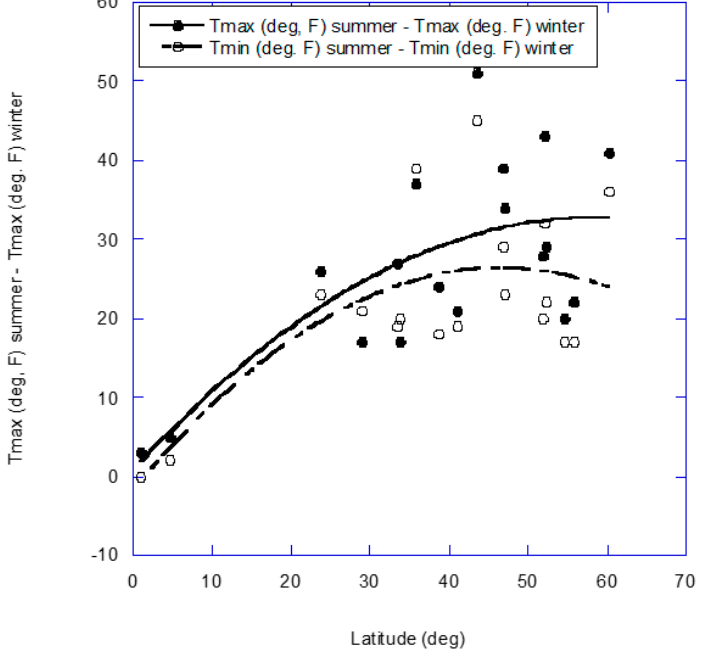
Figure 2. Seasonal variation in high minus low ambient atmospheric temperature for the approximate center of population for 18 countries from Marti-Soler and colleagues [1]. The regression fits are second-order.